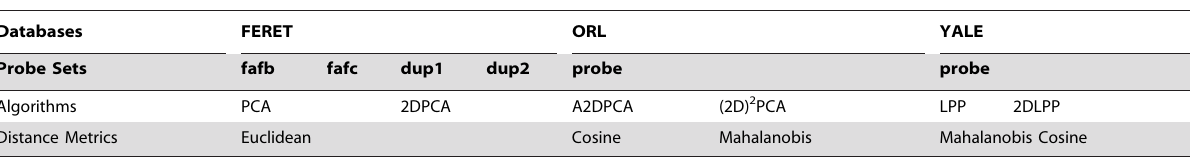
Table 2. Testing